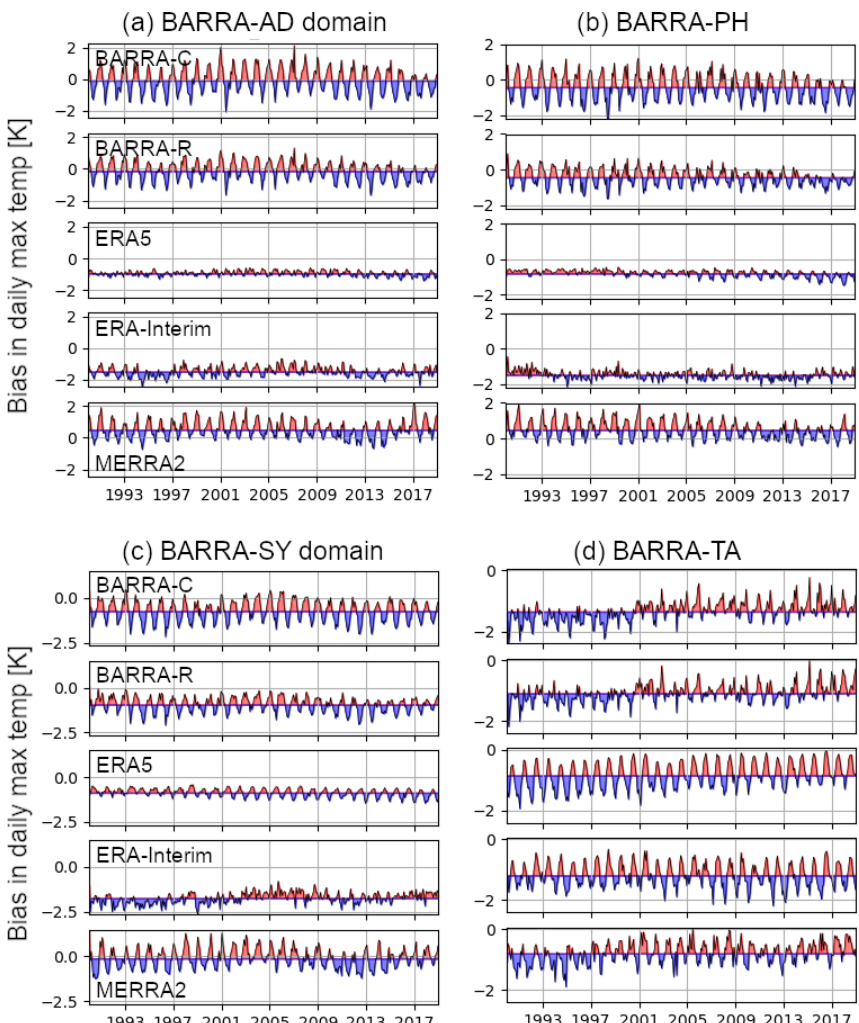
Figure 4. Time series of monthly mean difference in daily maximum temperature averaged over various BARRA-C domains with respect to AWAP. The time series are shaded around their individual 1990–2018